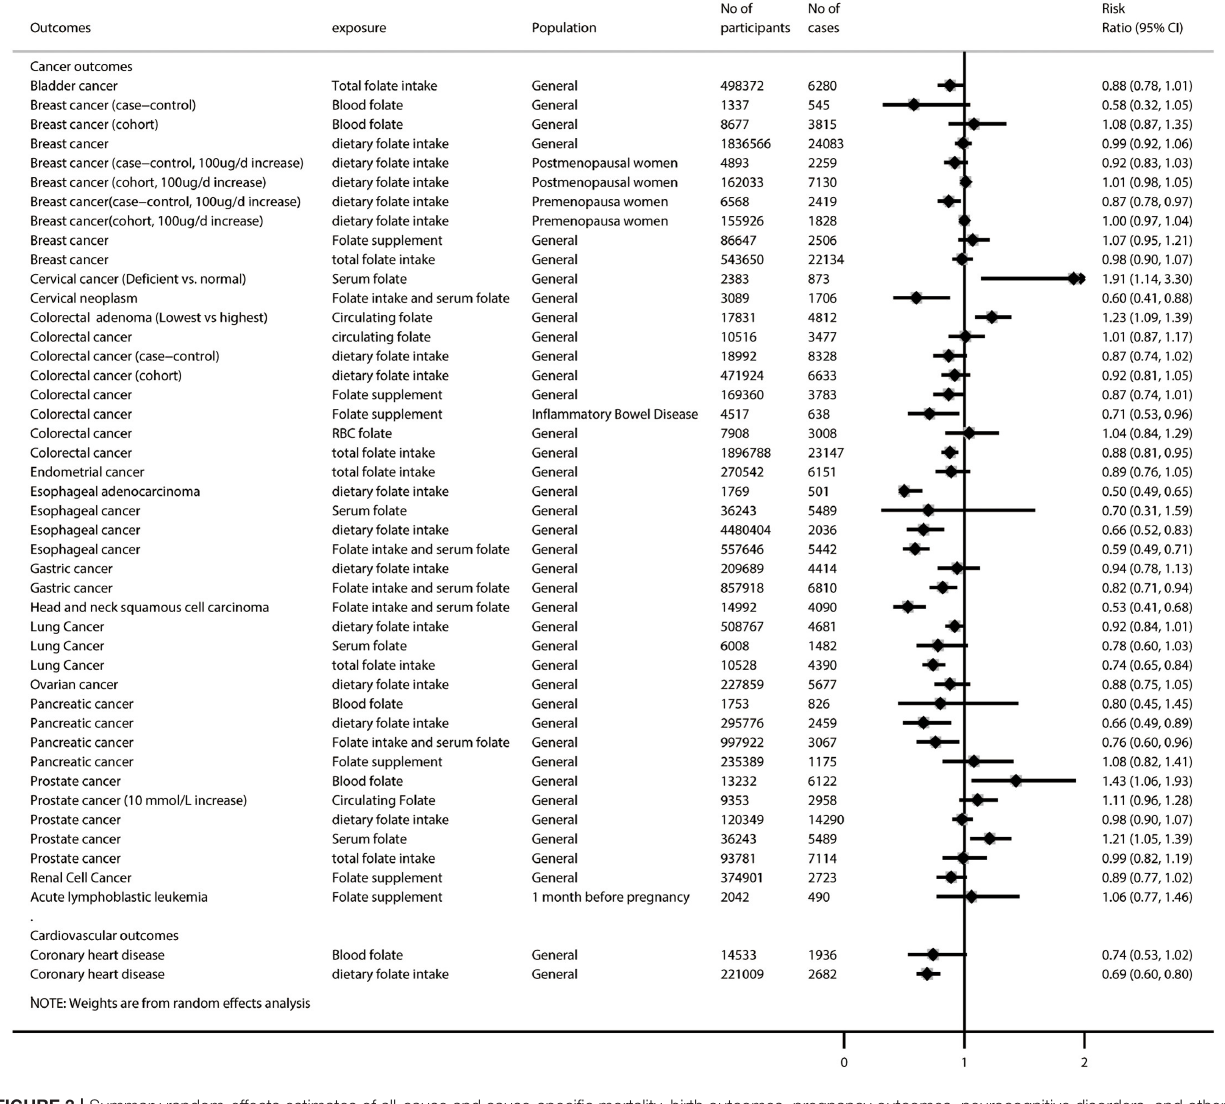
methodological level, and 14 (13.0%) were rated as